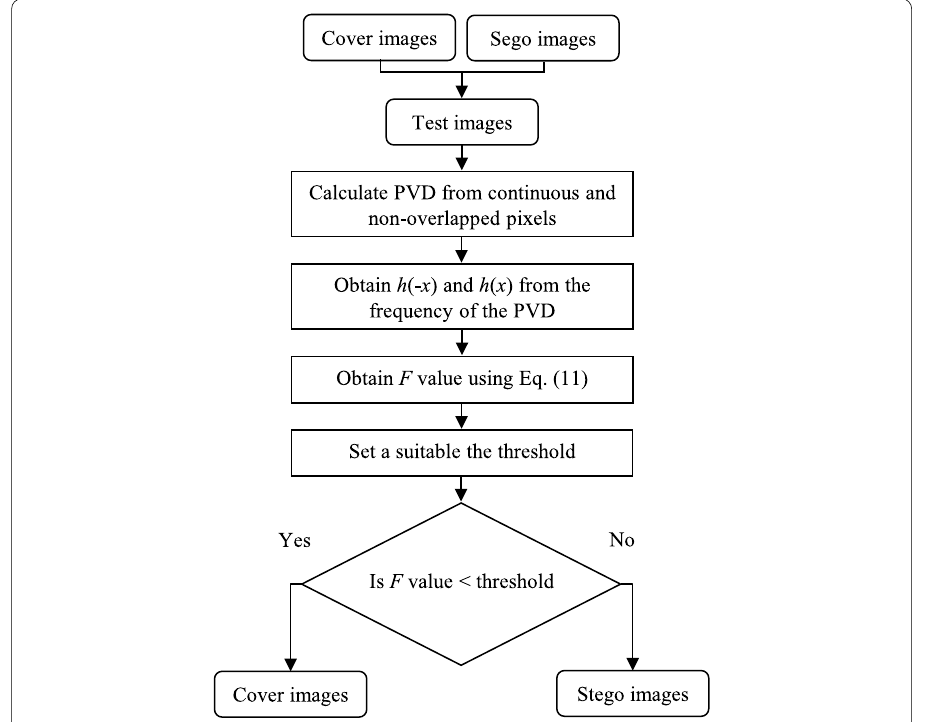
Fig. 7 Flowchart of the proposed